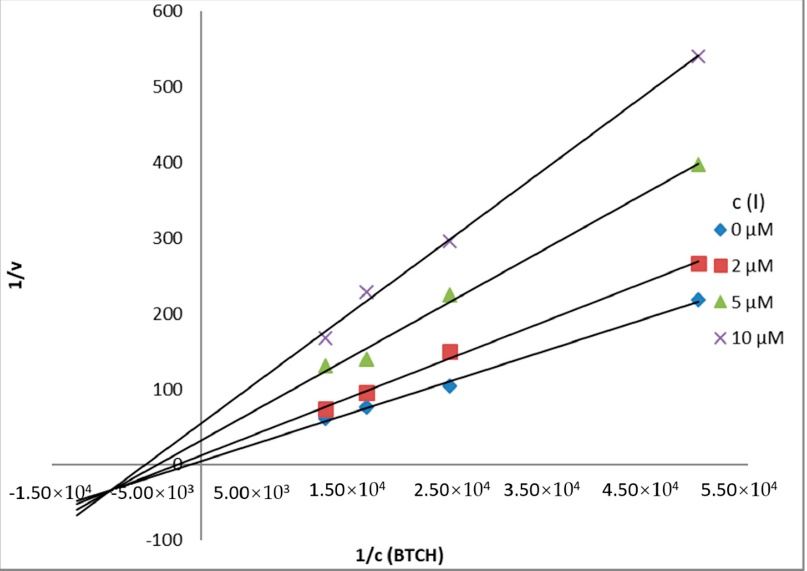
Figure 4. Lineweaver-Burk plot for BuChE inhibition (BTCH = butyrylthiocholine).